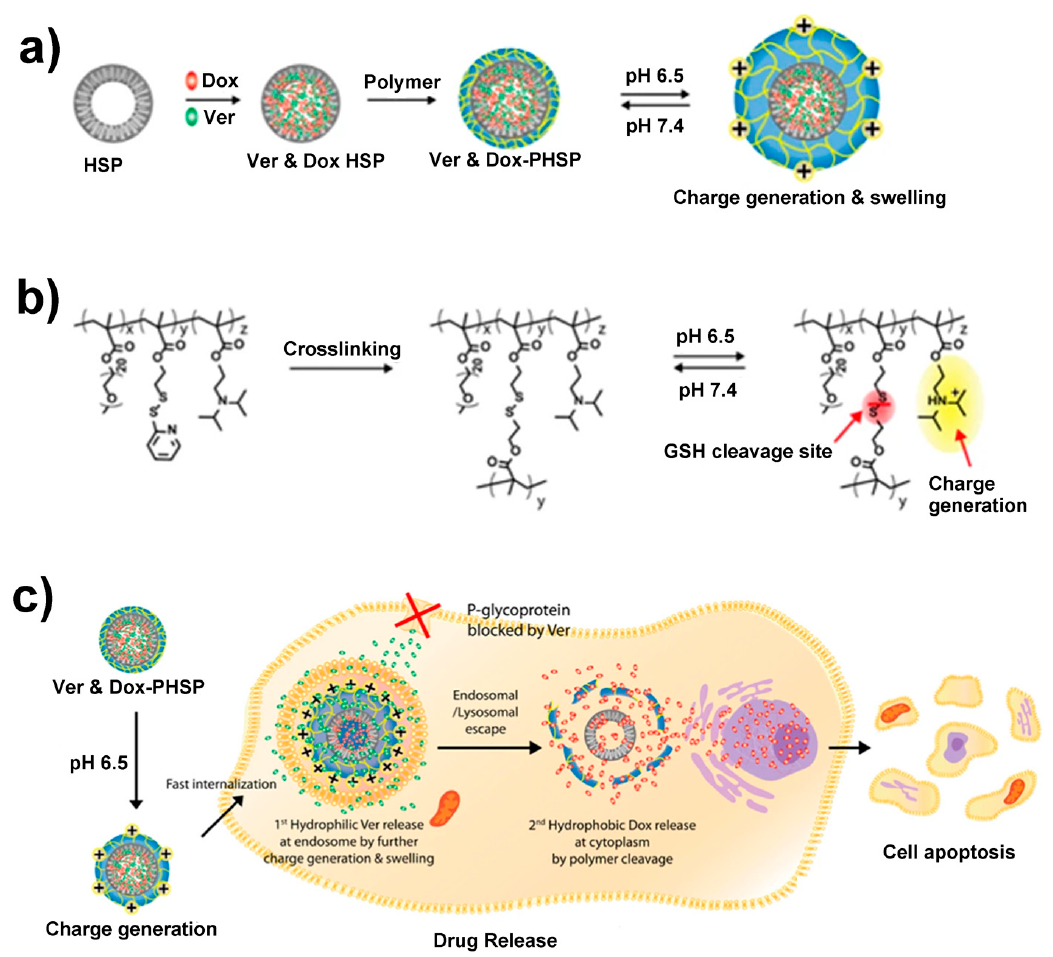
Figure 4. ( a ) Scheme for preparation of drug-loaded PEG(polyethylene glycol)–PDS(pyridine disulfide)–DPA{2-(diisopropylamino) ethyl methacrylate} copolymer-coated HSP (PHSP), ( b ) disulfide crosslinking, and pH-dependent cationic charge reversal by the protonation of the diisopropylamino group. ( c ) Schematic illustration of the cellular uptake, endosomal escape, and glutathione (GSH)-mediated drug release. Under tumoral acidic conditions (pH 6.5), positive charge reversal results in a fast cellular uptake. Further increase of the positive charge of the polymer in the endosome (pH 5.0–5.5) induces the swelling of the polymer, followed by the release of hydrophilic Ver, facilitating the endosomal escape of the nanoparticles. In the presence of intracellular GSH, the second drug, hydrophobic Dox, is released. Adapted from [59] with permission from Springer Nature